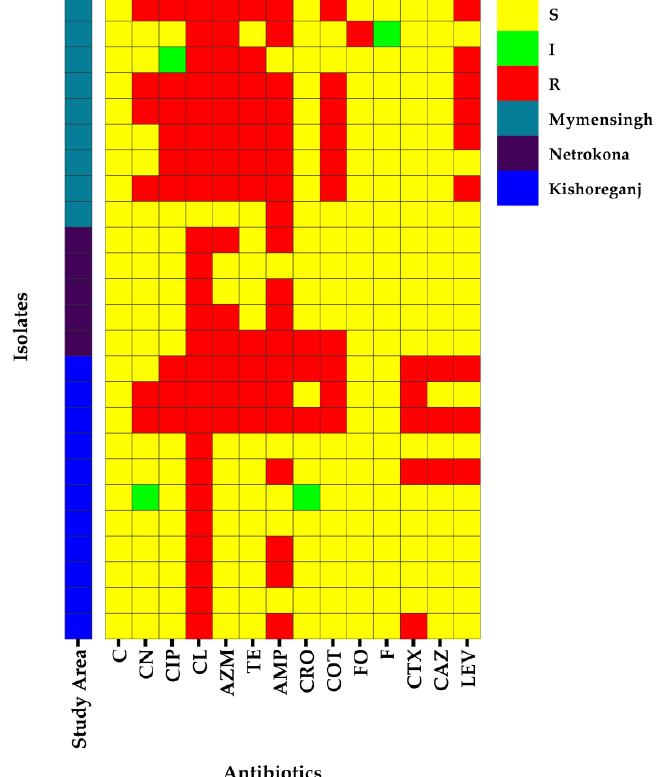
Figure 1. Heatmap showing the distribution of antibiogram profiles in 25 C. freundii isolates detected from cloacal swabs of ducks, LEV = levofloxacin; CAZ = ceftazidime; CTX = cefotaxime; F = nitrofu- rantoin; FO = fosfomycin; COT = cotrimoxazole; CRO = ceftriaxone; AMP = ampicillin; TE = tetracy- cline; AZM = azithromycin; CL = Cephalexin; CIP = ciprofloxacin; CN = gentamycin; C = chloram- phenicol, S = Sensitive, I = Intermediate, R =